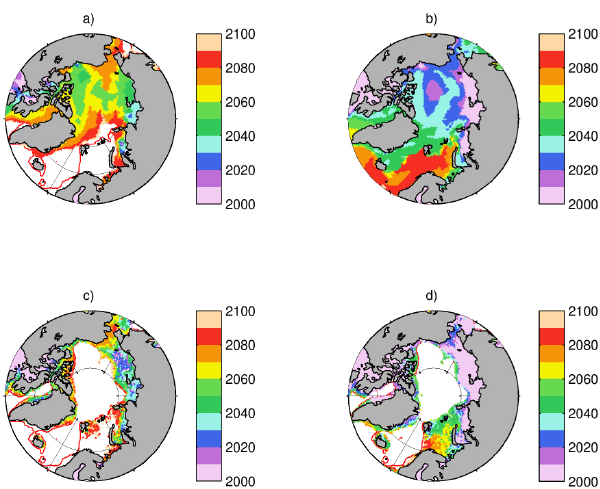
Fig. 6. The first occurrence of a monthly mean undersaturated sur- face waters in respect to calcite (a) and aragonite ( b , years). The same for the shelf bottom waters at the depth of the deepest model vertical grid box (c, d)